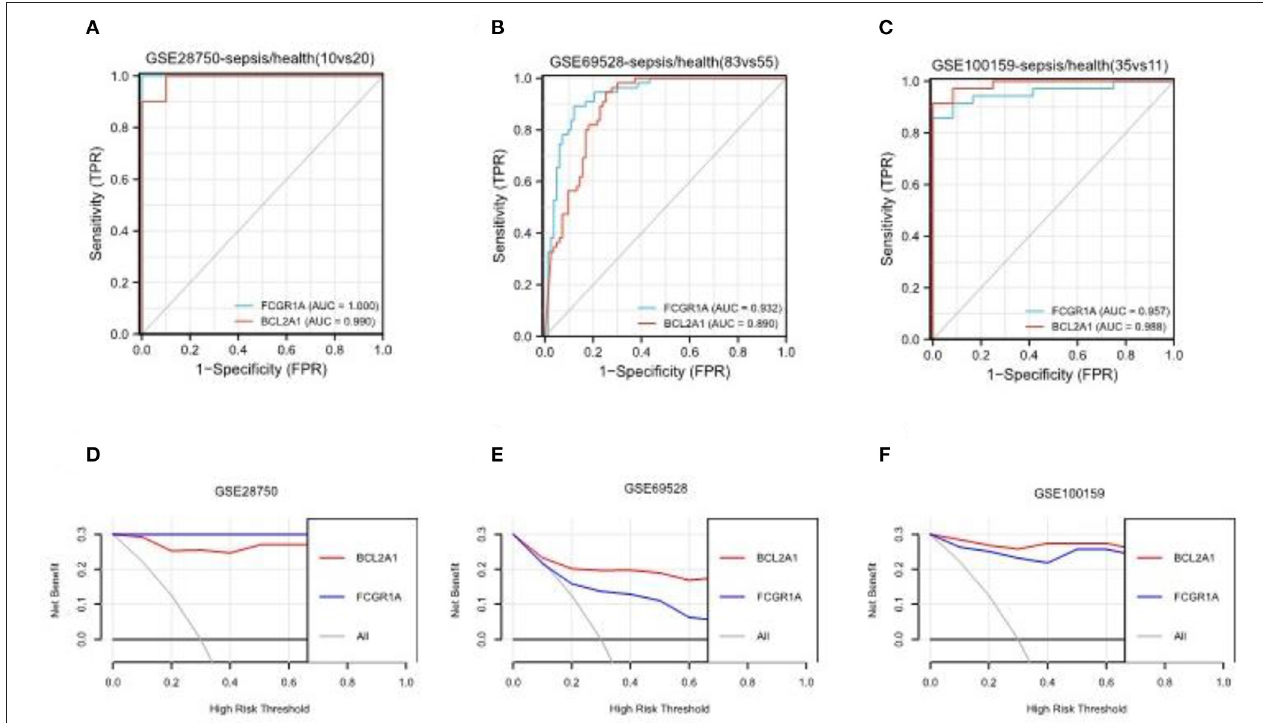
FIGURE 8 | ROC curve analysis and decision curve analysis of BCL2A1 and FCGR1A in three sepsis datasets. (A–C) BCL2A1 revealed a high AUC value in all three datasets, suggesting its diagnostic value in sepsis. (D–F) DCA of BCL2A1 and FCGR1A in the three datasets. ROC, receiver operating characteristic; AUC, area under the curve; DCA, decision curve